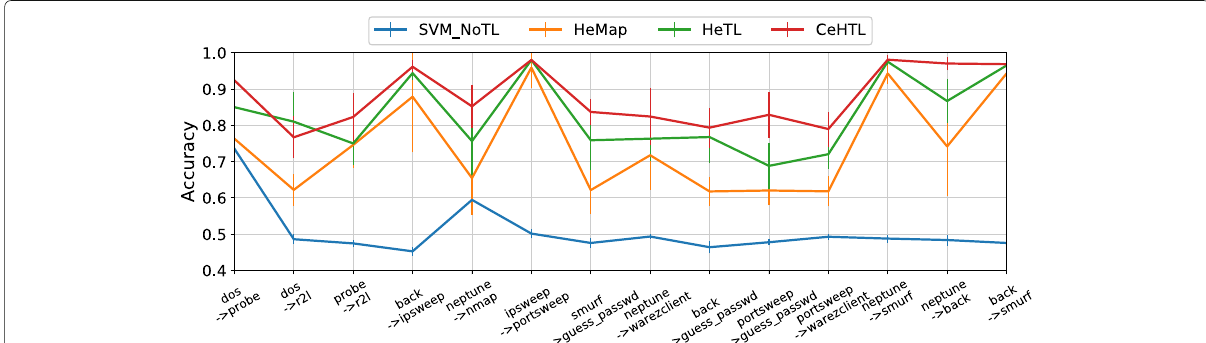
Fig. 4 Performance comparison of accuracy on unknown network attacks detection, sample size = 1000